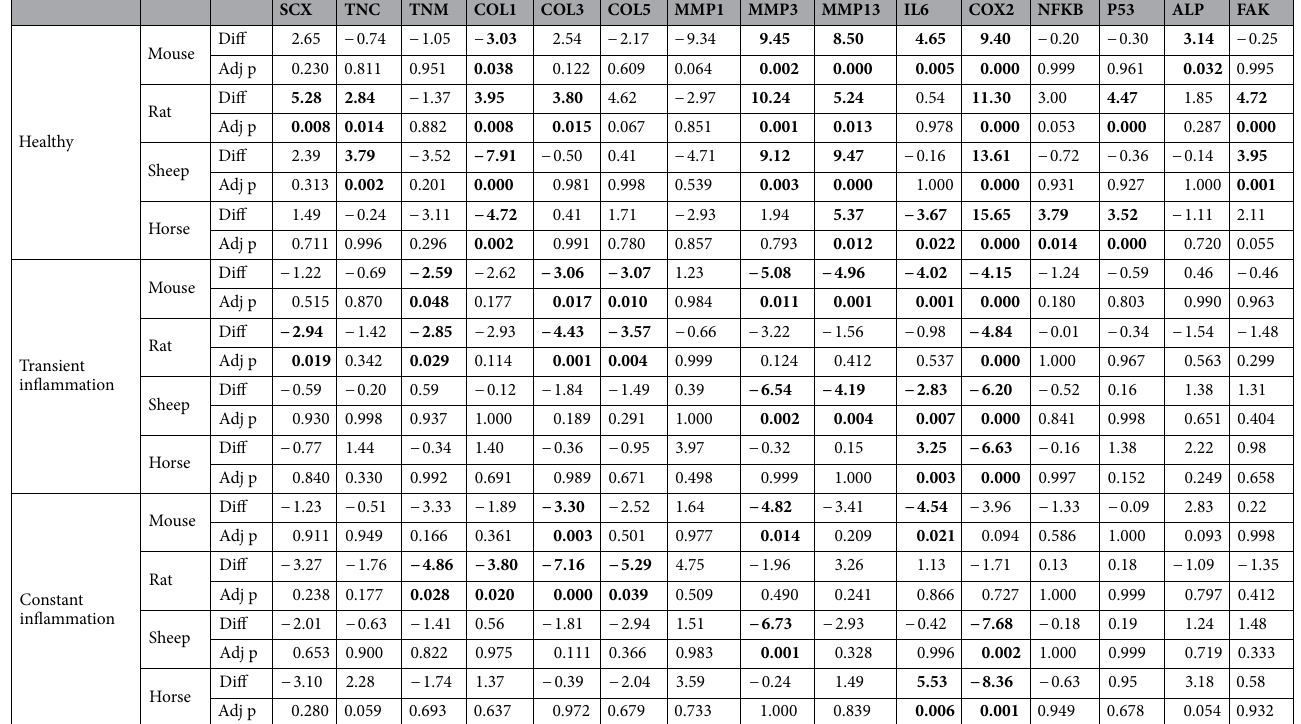
Table 2. Mean difference to human and p-values of the gene expression calculated with ANOVA of healthy, transiently inflamed and constantly inflamed tenocytes of the four animal model species. Significant p-values